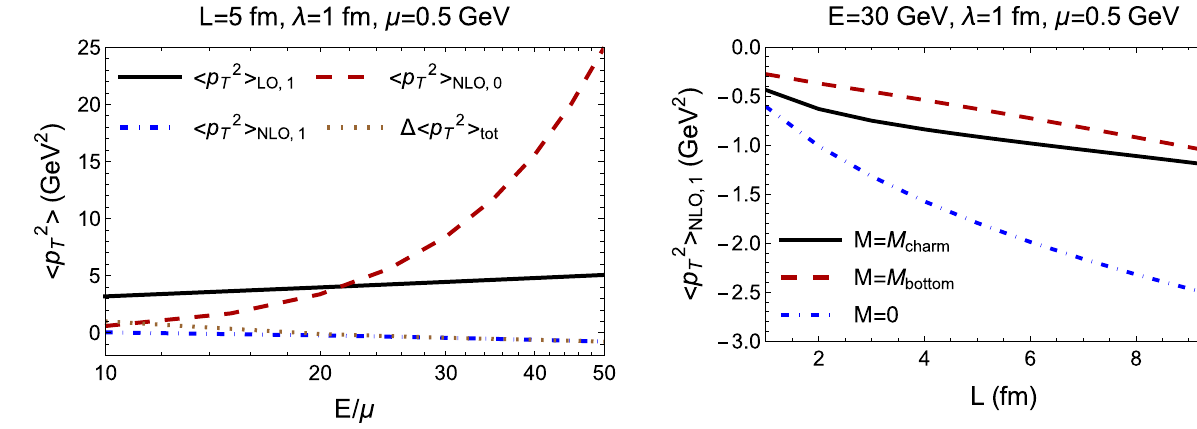
Fig. 9 The radiative broadening of charm (solid), bottom (dashed), Fig. 8 The LO, NLO, and vacuum-subtracted total transverse momen- and massless (dot-dashed) quarks at first order in opacity, as a function tum picked up by a charm quark ( M = 1 . 5 GeV) propagating through a of the effective medium length L . The charm and bottom quark masses plasma characterized by L = 5 λ = 1 fm and μ = 0 . 5 GeV. We observe were taken to be M = 1 . 5 GeV and M = 4 . 75 GeV respectively (cid:4) ln ( E /μ) and ( ln ( E /μ)) 2 scaling for the LO broadening (cid:2) p 2 LO, 1 and T (cid:4) first order in opacity NLO broadening (cid:2) p 2 NLO, 1 respectively T